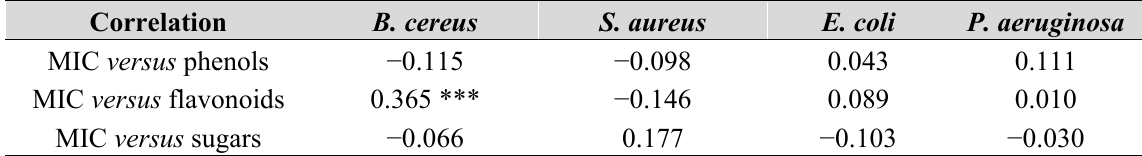
Table 3. Pearson’s correlation coefficients between MIC and phenols, between MIC and flavonoids, and between MIC and sugars for the bacteria studied.